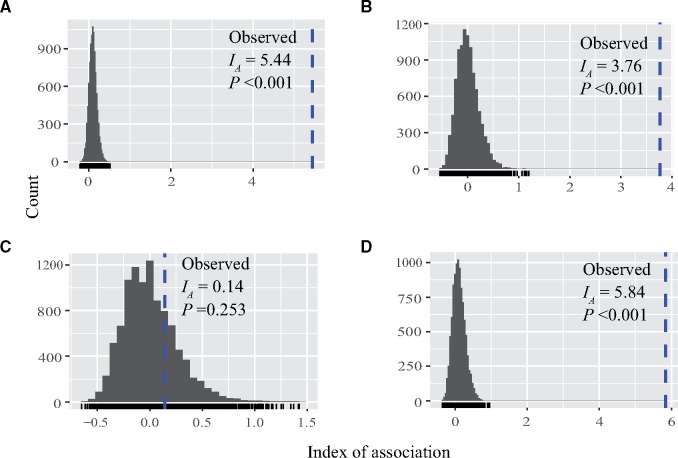
—Index of association (IA) test of recombination for all Mesorhizobium individuals and for each clade. Based on the frequency distribution of IA, the hypothesis of no linkage among markers is rejected (P < 0.001) for all data (A), Clade I (B), and Clade III (D), indicating clonal populations. There is no evidence of linkage disequilibrium among loci (P = 0.263) for Clade II (C), consistent with a sexual-like recombining clade.